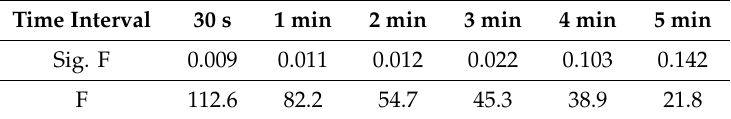
Table 1. Significance F and F values calculated by various time